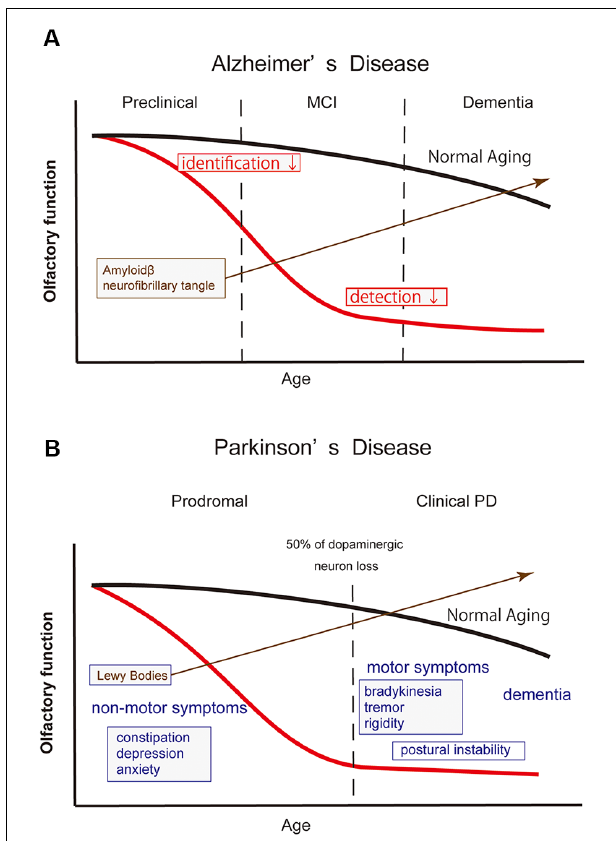
FIGURE 3 | Schematic drawing illustrating the olfactory dysfunction and time course of Alzheimer’s disease (AD) and Parkinson’s disease (PD). In both neurodegenerative diseases, the emergence of olfactory dysfunction precedes their definite diagnosis. The red and black lines in the drawing indicate the time course of olfactory function in patients and normal elderly individuals, respectively. (A) In AD, olfactory dysfunction emerges in its preclinical phase when cognitive function is still preserved. At the time, however, the accumulation of amyloid β already begins in the brain structures, including in the olfactory pathway. Odor identification ability deteriorates first, followed by a worsening in odor detection. (B) Definite diagnosis of PD is made by the emergence of motor symptoms when approximately 50% of dopaminergic neurons are lost in the substantia nigra. Olfactory dysfunction emerges in the prodromal phase, along with other non-motor symptoms. Lewy bodies are already observed in the olfactory system, including the OB. In clinical PD, the severity of olfactory dysfunction does not appear to be correlated with the disease duration or disease stages, suggesting that the degenerative changes in the olfactory neural structures have progressed at the time of